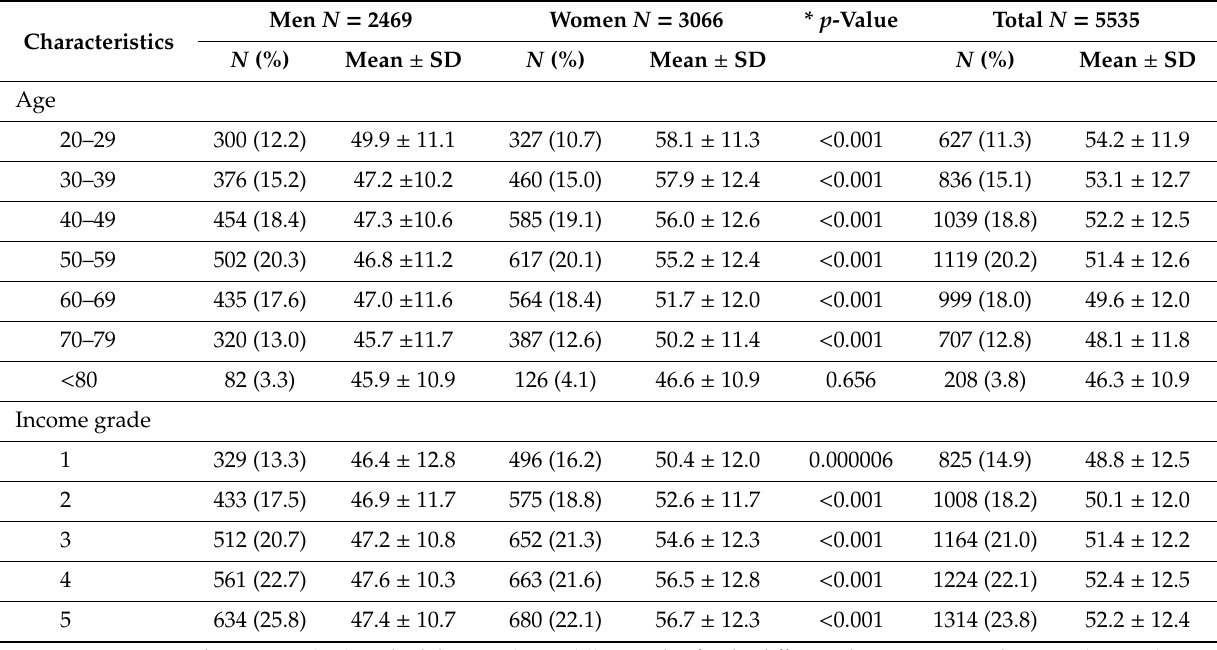
Table 2. Distribution of age and income grade depends on HDL-C. Data are expressed as mean ± SD (standard deviation) or N (%). * p value for di ff erence between men and women ( p <